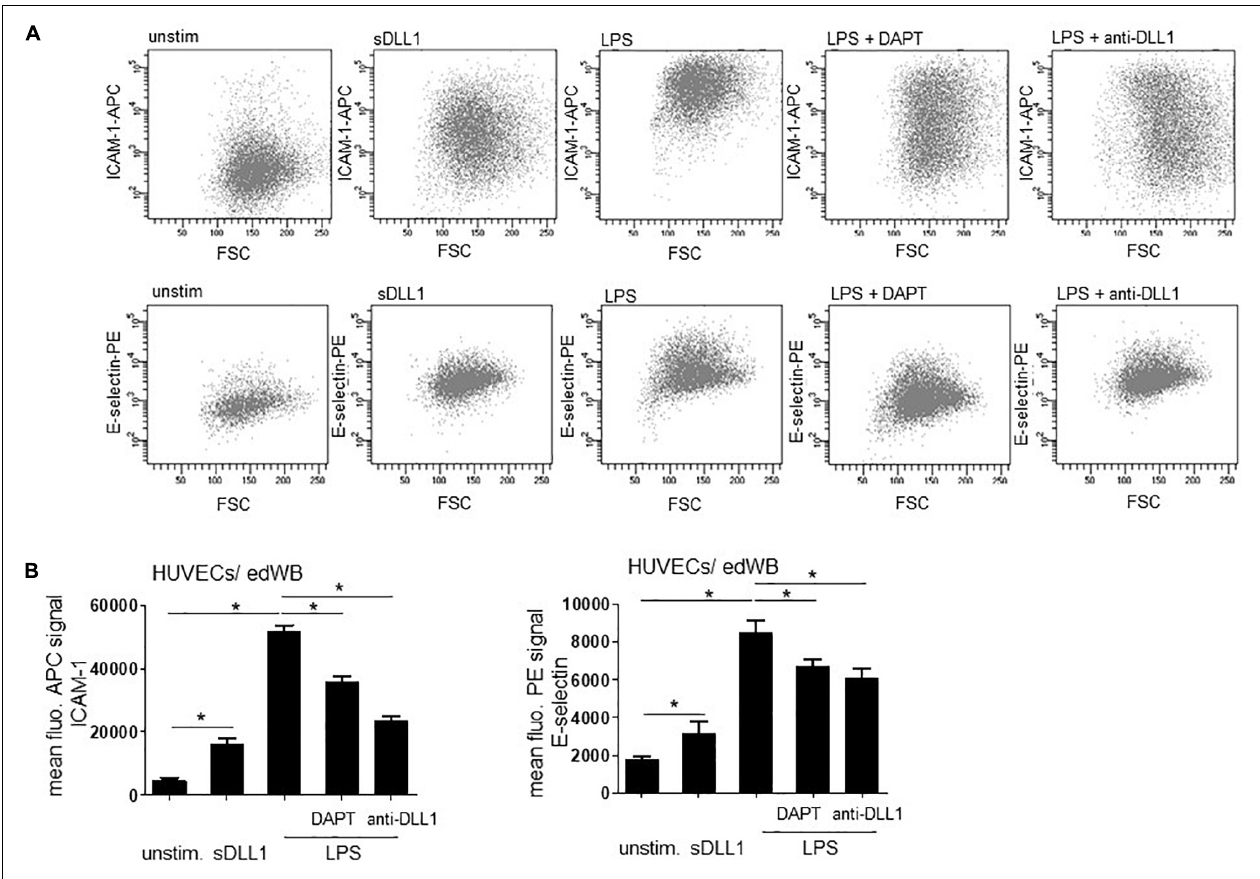
FIGURE 2 | Notch signaling promotes LPS-mediated endothelial cell activation. HUVECs/edWB coculture was stimulated with sDLL1 (5 µ g/ml), LPS (100 ng/ml), LPS + DAPT (1 µ M, pretreatment for 1 h), or LPS + anti-DLL1 antibody (5 µ g/ml) overnight. After removing blood and repeated washing, HUVECs were harvested and stained with anti-ICAM-1 antibody and anti-E-selectin antibody and analyzed by flow cytometry. (A) Dot blots of flow cytometry analysis. (B) Quantification of mean fluorescence of bound antibody (mean ± standard deviation; n = 3). Statistics: Prism9 software, one-sided Mann-Whitney U -test. * p ≤ 0.05.